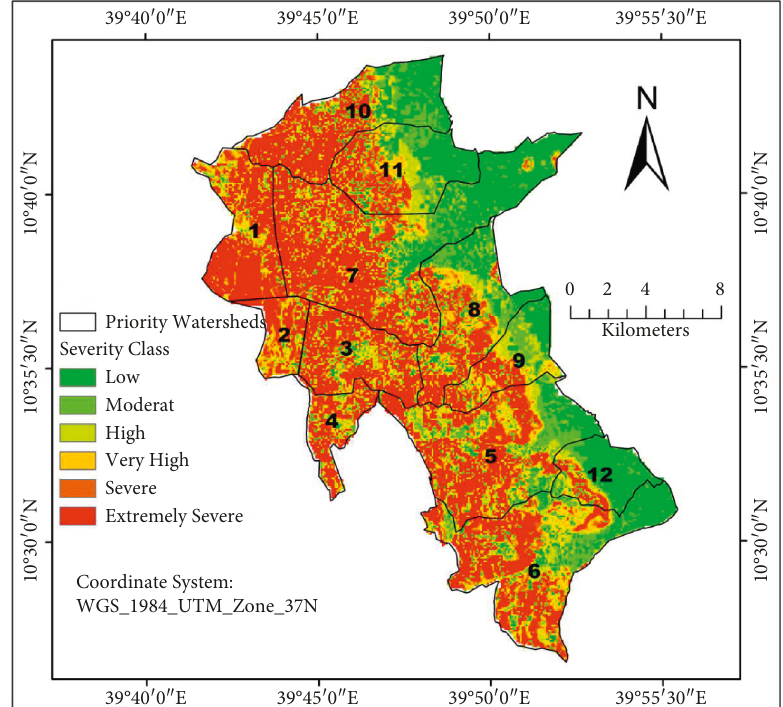
Figure 11: Map of microwatershed